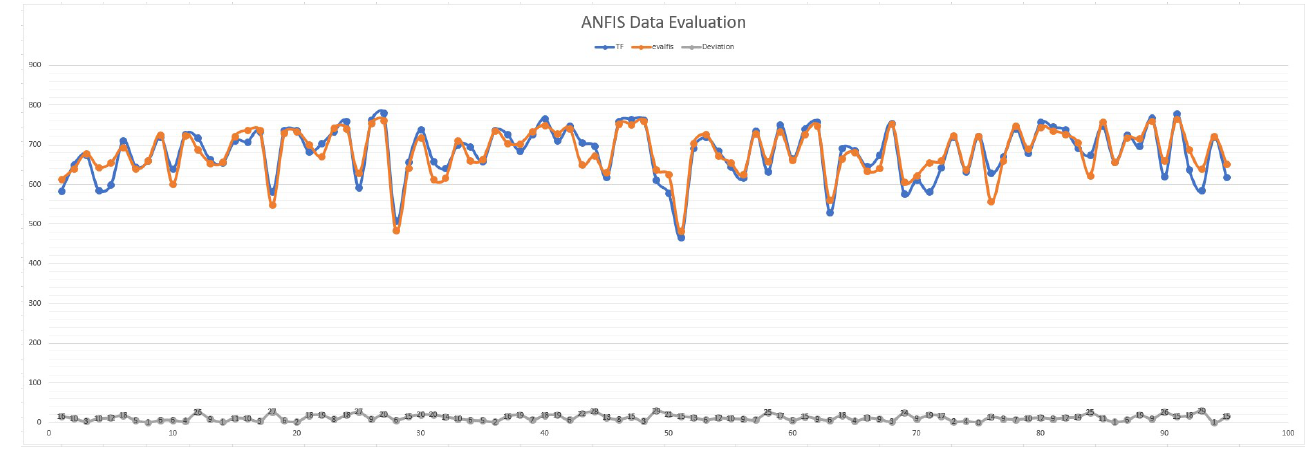
Figure 14. ANFIS